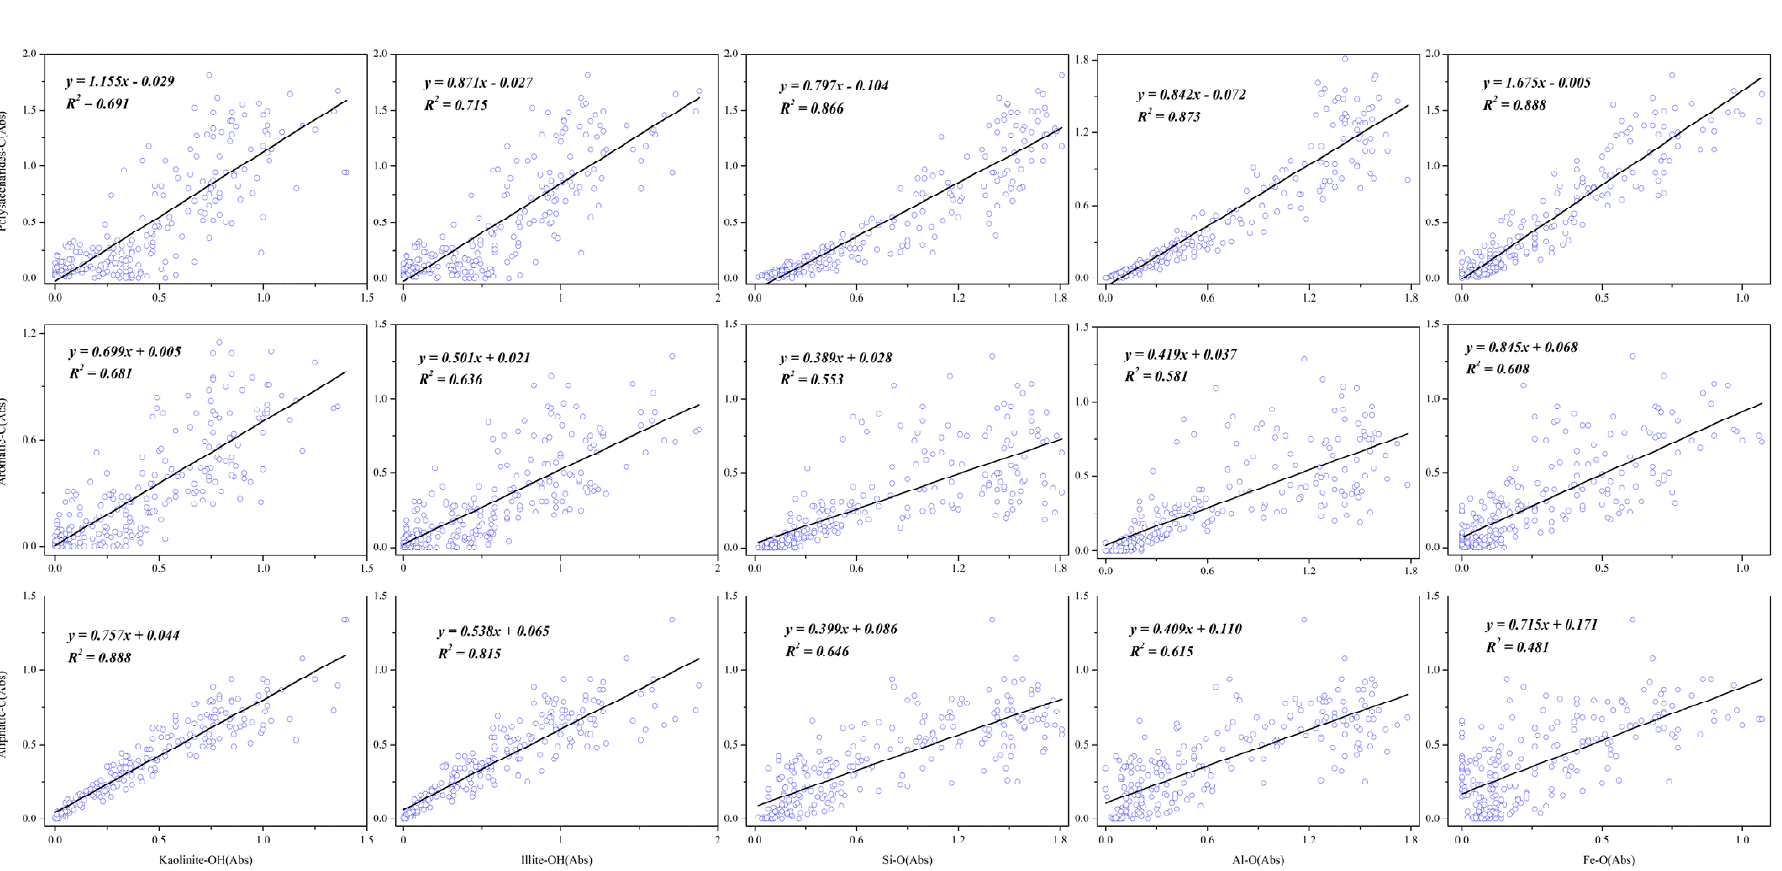
Figure 3. Correlation analysis between organic functional groups and minerals of the CK samples. Data were extracted from Figure 1 using Omnic 9.0 (Thermo Fisher Scientific Inc., Waltham, MA, USA). Table 3. The Correlation analysis between organic functional groups and minerals in soil aggregates as affected by different fertilizer treatments using SR-FTIR. Treatment